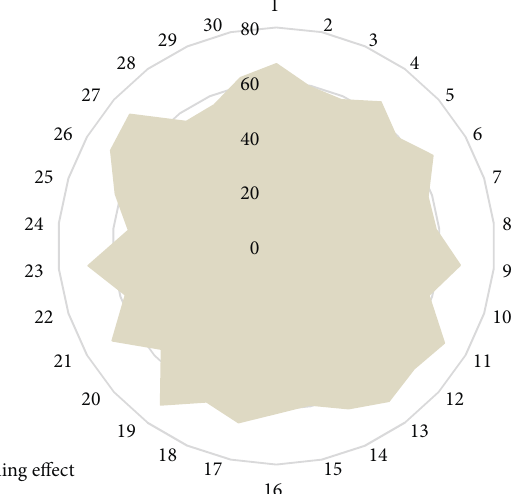
Figure 9: Experimental evaluation of the system’s effect on im- proving the teaching effect of college English